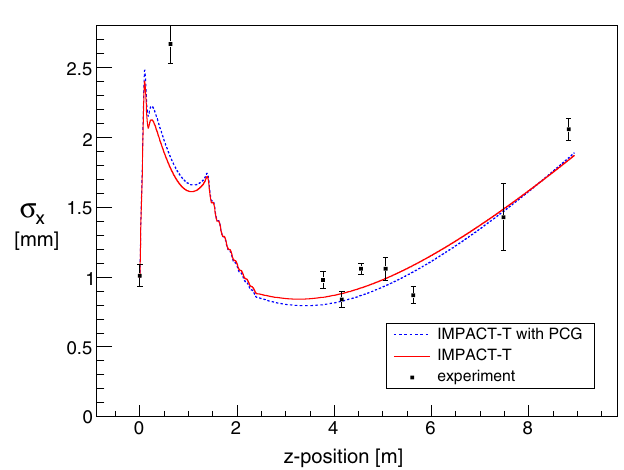
(cid:4) 32 , N (cid:4) i FIG. 14. (Color) Distribution 1: rms beam radius for the Fermilab/NICADD photoinjector: as measured in the lab (black dots) and as simulated with FFT-based IMPACT-T (red) and IMPACT-T with PCG (blue). Numerical simulations were done (cid:4) 32 grid and with N (cid:4) 200 000 particles, Daubechies on a N i wavelets of order 2 and no thresholding. The configuration of the lattice is different from the one used to generate Fig.